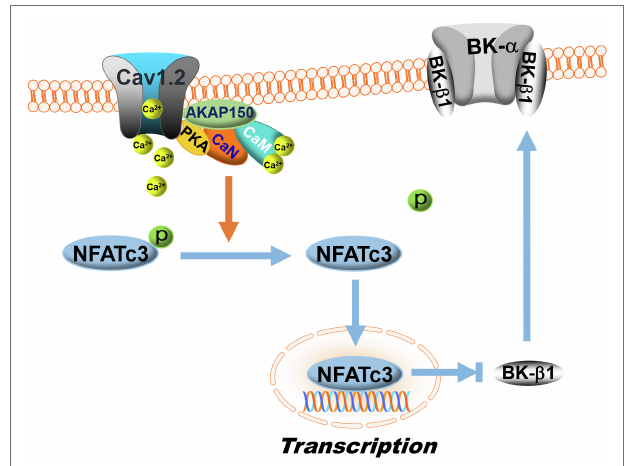
FIGURE 5 | Regulation of BK- β 1 expression by NFATc3 signaling. Calcineurin is a Ca 2+ /calmodulin (CaM)-activated phosphatase. In the membranes of vascular SMCs, AKAP150 proteins anchor calcineurin (CaN) with PKA and L-type Ca 2+ channels (Cav1.2) to form dynamic Ca 2+ signaling complexes. L-type Ca 2+ channel activity is upregulated by PKA, which increases Ca 2+ influx. Upon Ca 2+ binding to calmodulin, calcineurin is activated, which then dephosphorylates NFATc3 and promotes NFATc3 nuclear translocation, inhibiting BK- β 1 mRNA expression. In DM, the activity of the AKAP150-NFATc3 signaling pathway is upregulated, resulting in enhanced suppression of BK- β 1 expression and impaired BK channel function in vascular SMCs. The symbol “p” represents protein